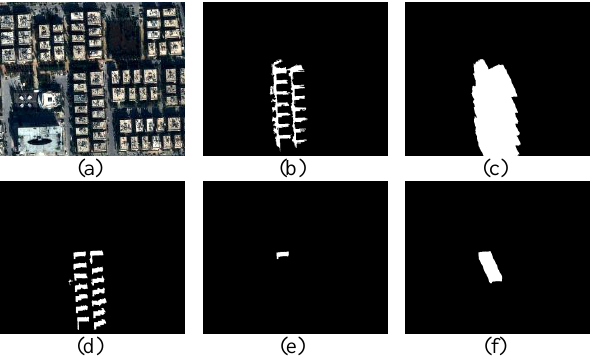
Figure 4. (a) Geoeye-1 image (RGB), (b) a single shadow component detected, and (c) the large ROI region generated. (d) The foreground information T F (without refinement) generated from the shadow component in (b). (e) One of the T F regions and (f) the ROI formed for that region after